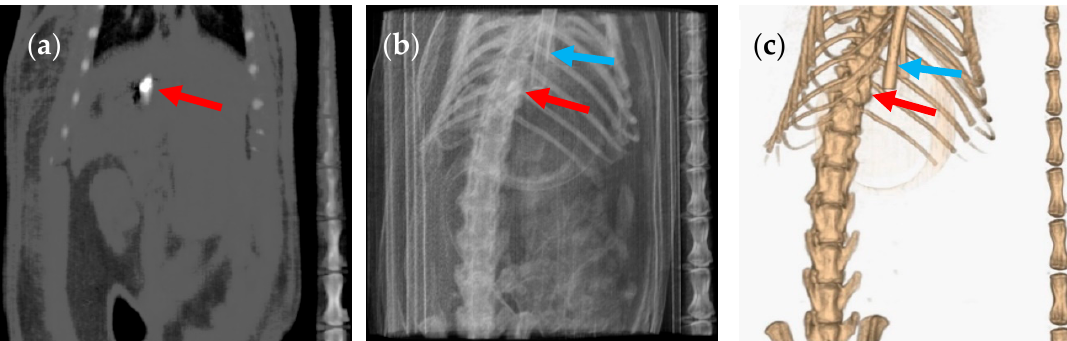
Figure 2. ( a ) Coronal computed tomography (CT) slice of the size 9 capsule in the stomach of the rat, ( b ) planar CT projection and ( c ) three-dimensional rendered CT image of the same animal. The capsule is indicated by a red arrow and the breathing sensor by a blue arrow. Image taken under anaesthesia.